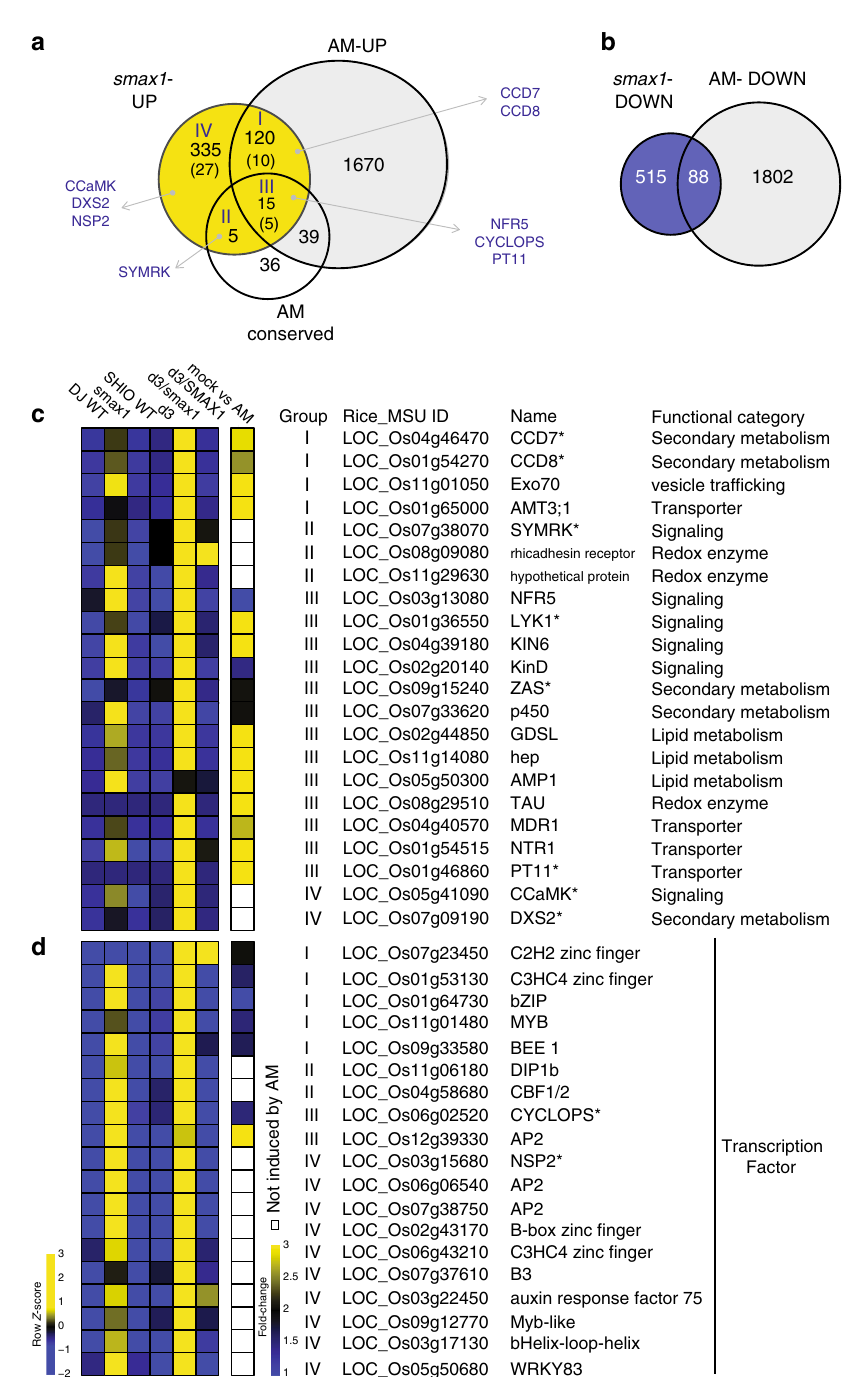
Fig. 4 SMAX1 regulates AM-associated genes. a The Venn diagram shows commonly upregulated genes in smax1 and during AM symbiosis 51 , or overlapping with genes conserved in AM-host plant species 52 . smax1- UP represents the genes upregulated either in smax1 or d3/smax1 . The number in parenthesis indicates the number of genes that are not expressed in wild-type but induced in either smax1 or d3/smax1 . Genes with known function in AM symbiosis are shown in capital letters. b The Venn diagram displays commonly suppressed genes in smax1- DOWN and during AM symbiosis 51 . c , d The heatmap depicts relative expression levels and fold-change of induction during AM symbiosis of key genes involved in AM symbiosis, and of AM conserved genes ( c ) and transcription factors ( d ) that were induced in either smax1 or d3/smax1 . Asterisk indicates genes whose functions are previously characterized (See Supplementary Table